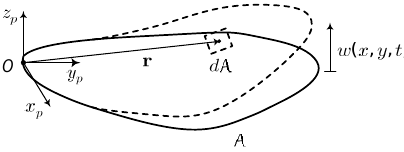
Figure 1. Wing Model in the Wing Body